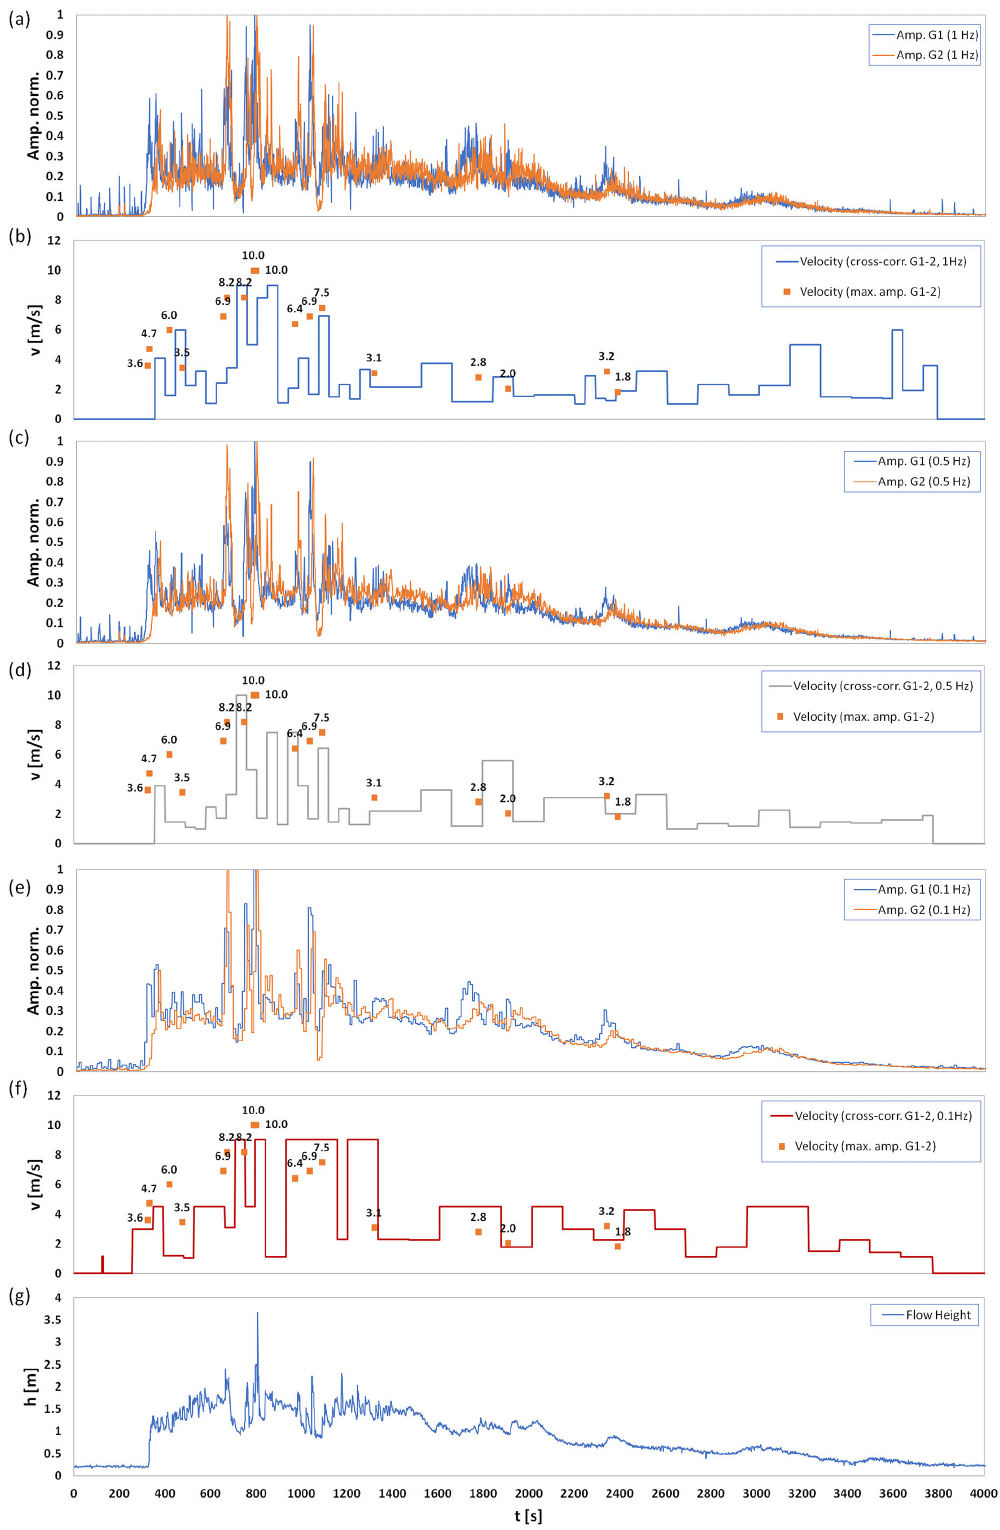
Figure 3. Debris flow at Lattenbach on 30 July 2017: (a, c, e) normalized amplitudes of the two geophones (G1, G2), (g) flow height, and (b, d, e) velocity estimation based on maximum values and cross-correlation (compared for sampling rates of 1, 0.5, and 0.1Hz)